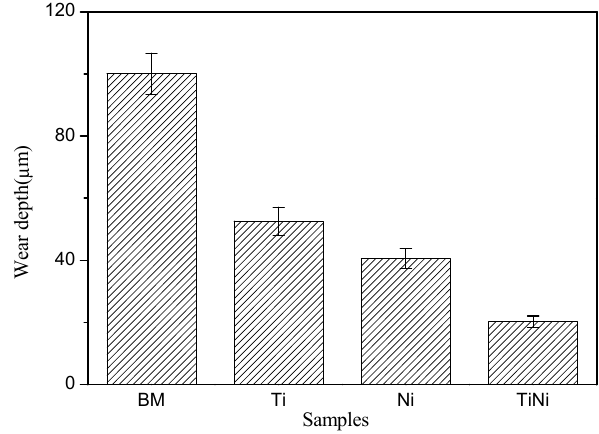
Figure 6. Wear depths of different samples.